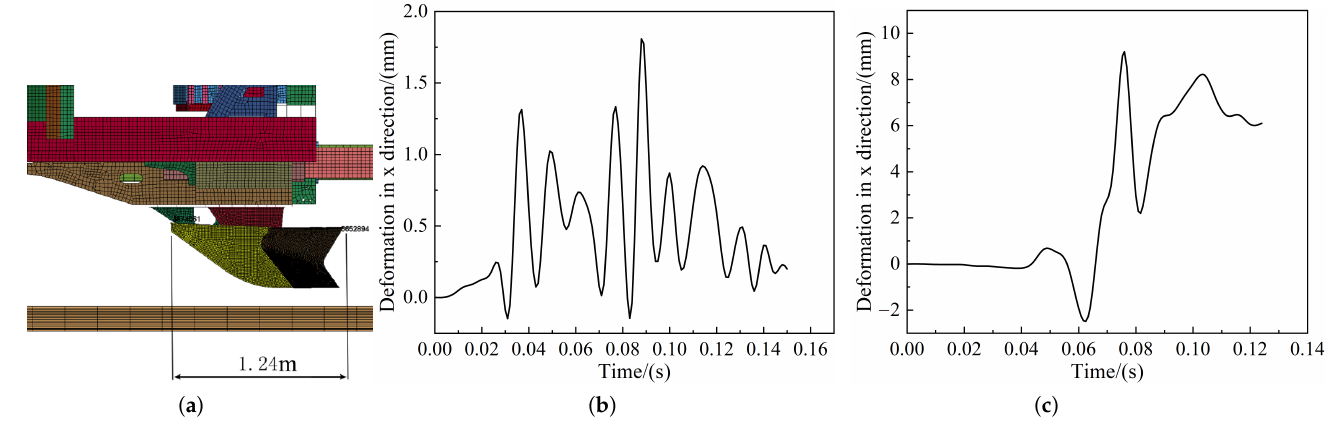
Figure 25. Deformation of the cowcatcher situation: ( a ) Schematic diagram of the location of the deformation test point of the cowcatcher; ( b ) deformation curve of pig frontal collision cowcatcher; ( c ) deformation curve of pig offset collision cowcatcher.